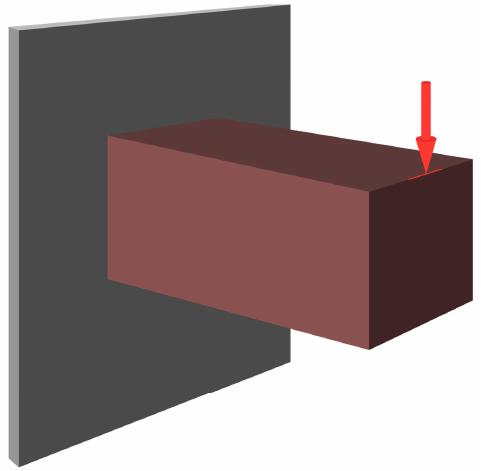
Figure 5. Display of boundary conditions in Inspire software.